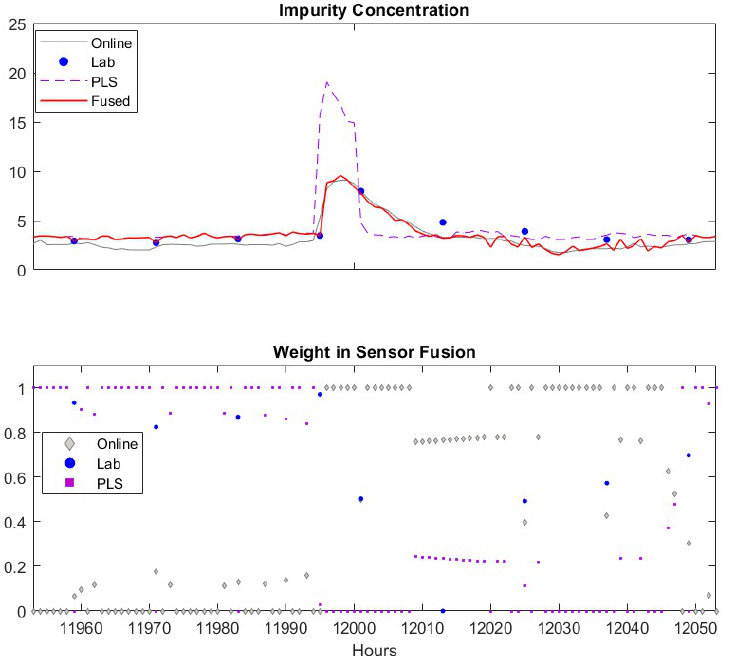
Figure 7. Sensor readings of quality variable around when the true alarm occurs. Upper figure: Comparisons of lab data (●), online analyzer data ( ─ ), PLS software sensor data (--) and fused value ( ─ ). Lower figure: Weights of lab data (●), online analyzer data ( ♦ ), PLS software sensor data ( ■ ).